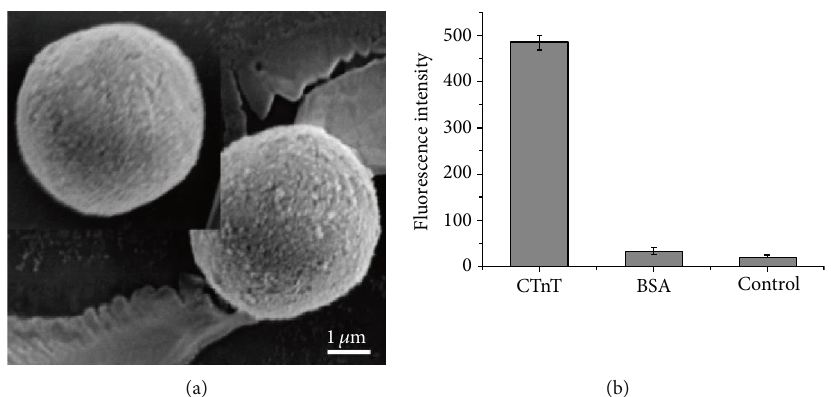
Figure 2: (a) SEM images of magnetic microspheres (in the upper left corner) and magnetic microspheres – cTnT (in the center). (b) Biological characteristics of microspheres – cTnT and microspheres –